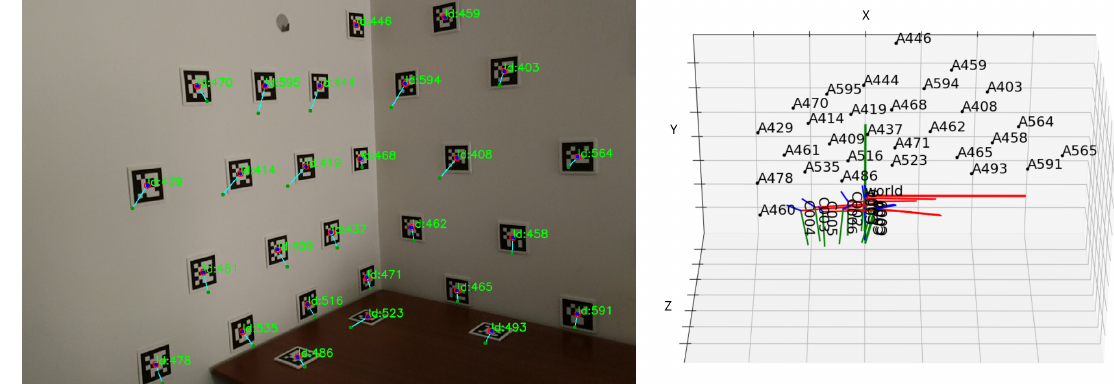
Figure 3. Visualisation function: (left) Aruco marker detected position in red (target of optimization), initial projection in green, current projection in dark blue, drawn over one image; (right) 3D representation of the position of the cameras and aruco markers in the scene.